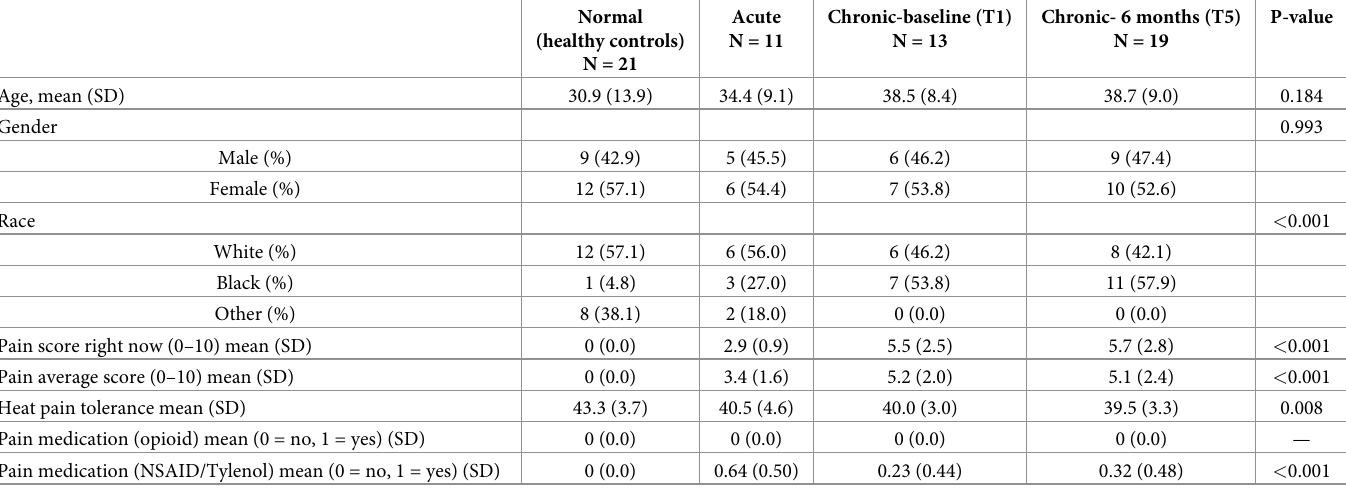
Table 1. Demographics and pain